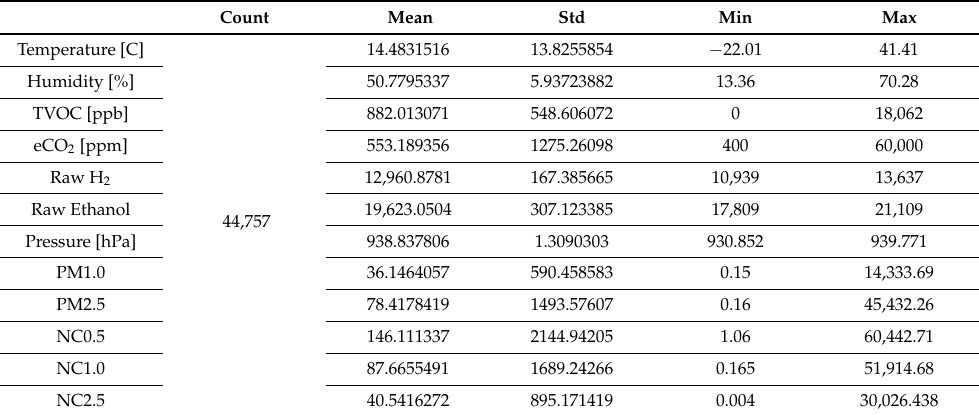
Table 3. The statistical data of samples when the fire alarm was